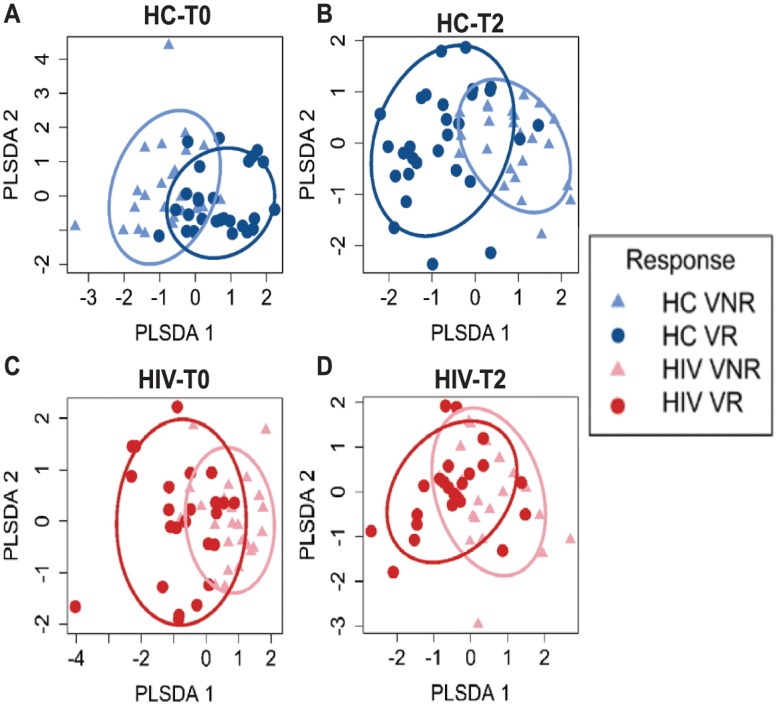
Identification of Ag.pTfh variables at T0 and T2 that are associated with FC H1N1 Ab titer at T2 in HCs and HIV+ individuals.LASSO and PLSDA identified 4 variables at T0 and 3 variables at T2 for HC (blue) and 3 variables at T0 and 2 variables at T2 for HIV+ individuals (red), which were selected for their association with FC H1N1 Ab titer shown in Tables 2, 3, 4 and 5. Underlying data used in the generation of this figure can be found in S1 Data. Ab, antibody; Ag.pTfh, antigen-specific peripheral T follicular helper; FC, fold change; HC, healthy control; LASSO, least absolute shrinkage and selection operator; PLSDA, partial least squares discriminant analysis; VNR, vaccine nonresponder; VR, vaccine responder.